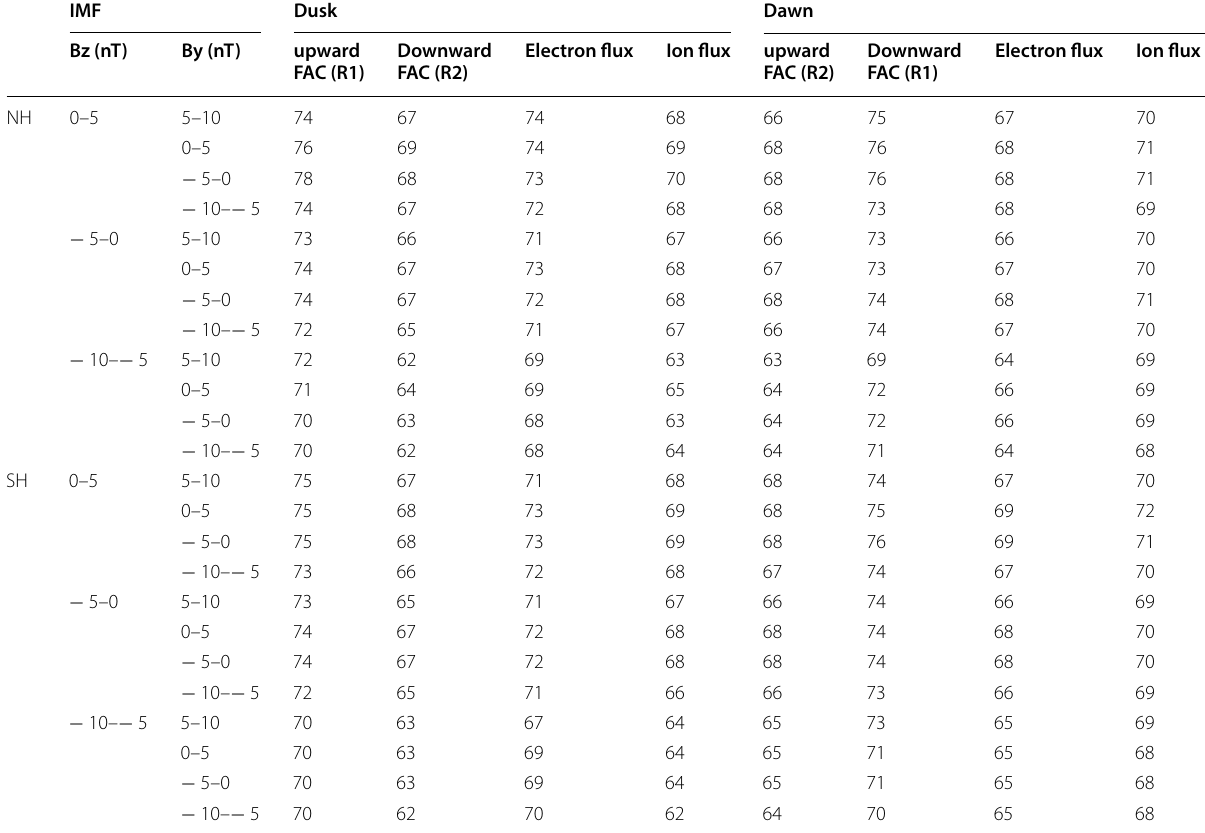
Table 1 The MLAT of peaks for upward/downward FAC, electron energy flux, and ion energy flux, separately for the dusk and dawn sides, as well as for the two hemisphere. Only the conditions with Bz < 5 nT have been considered IMF Dusk Dawn Bz (nT) By